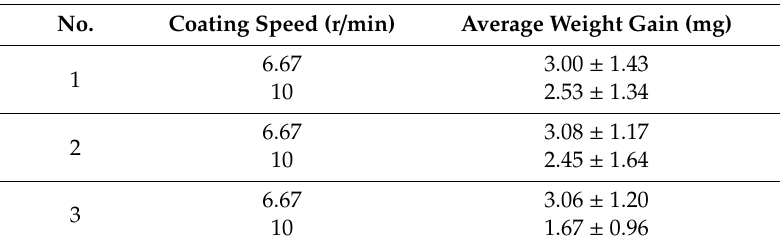
Table 3. Weight gain per unit time at di ff erent coating